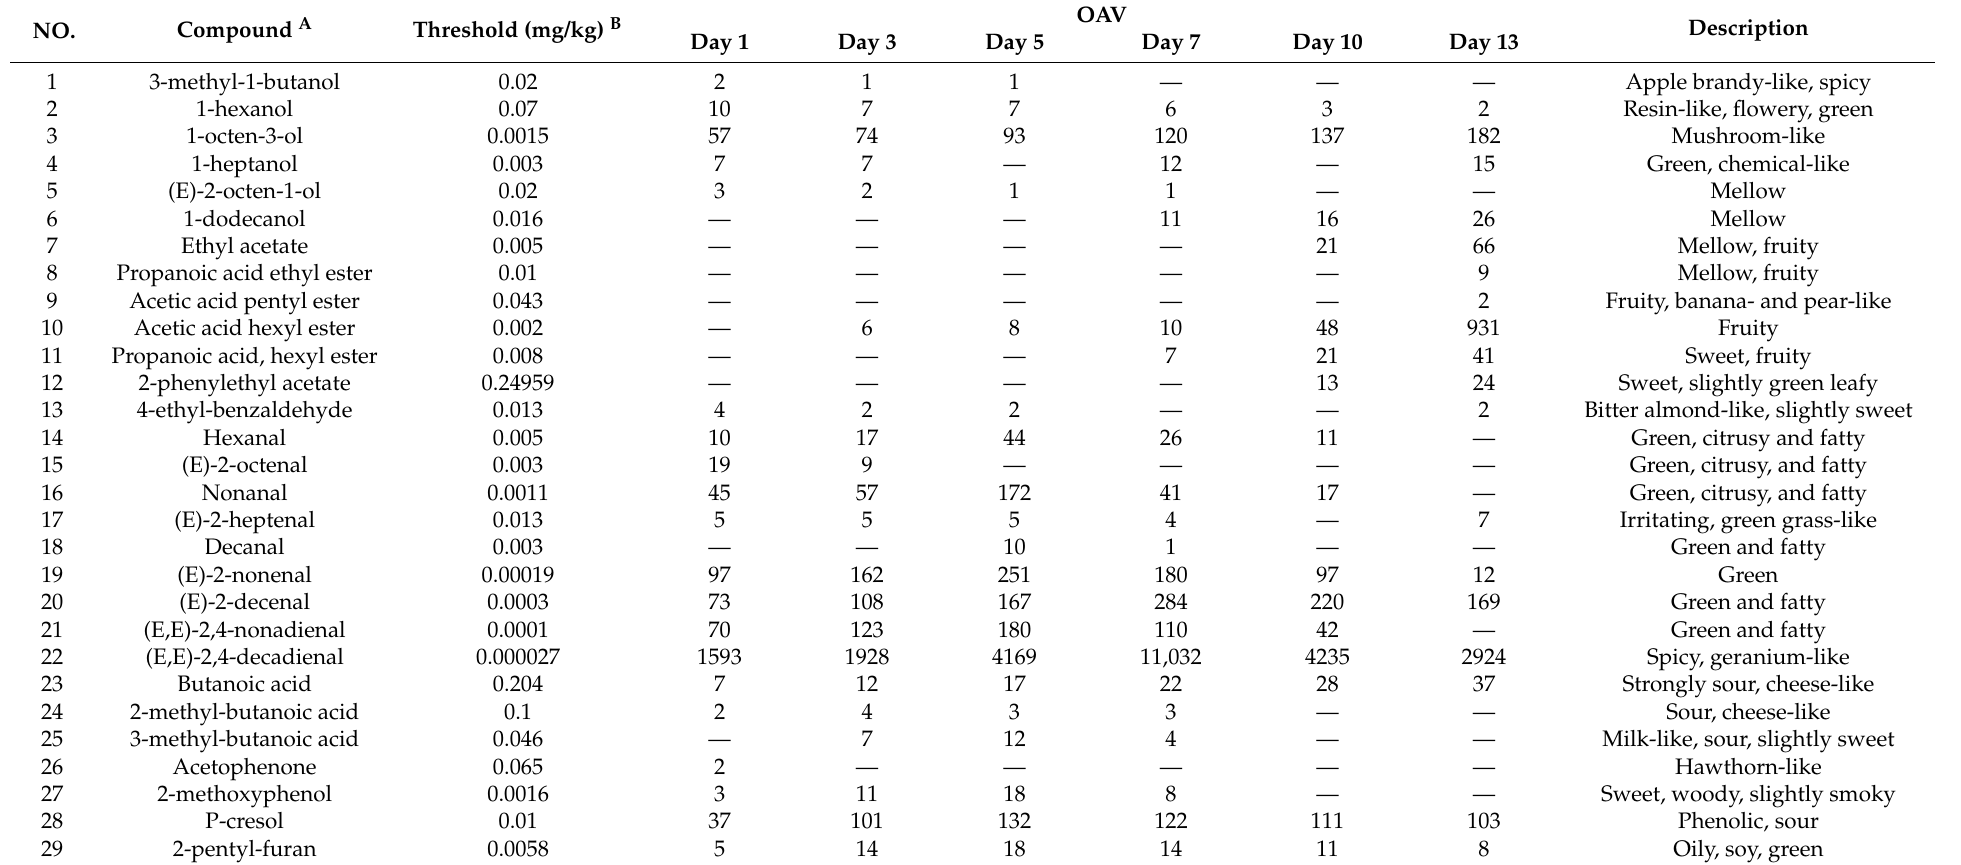
Table 3. Thresholds and OAVs ( ≥ 1) of the volatile compounds in the stinky tofu during